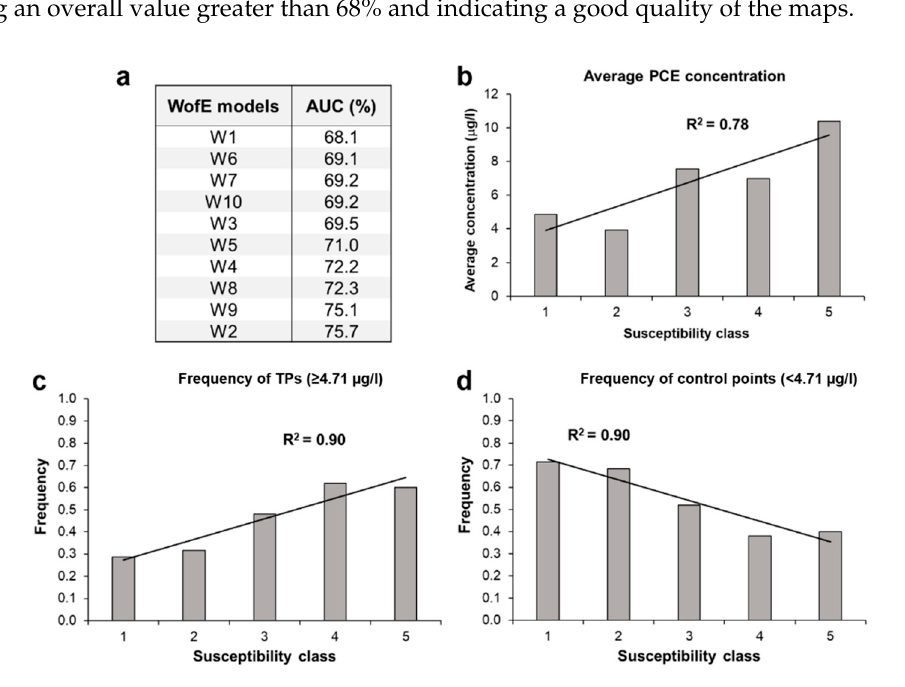
Figure 8. ( a ) area-under-the-curve (AUC) values for the ten post probability outputs. Histograms of the average PCE concentration ( b ), the frequency of the training points ( c ), and the control points ( d ) in each susceptibility class of the map in Figure 6a. The susceptibility increases from class 1 to class